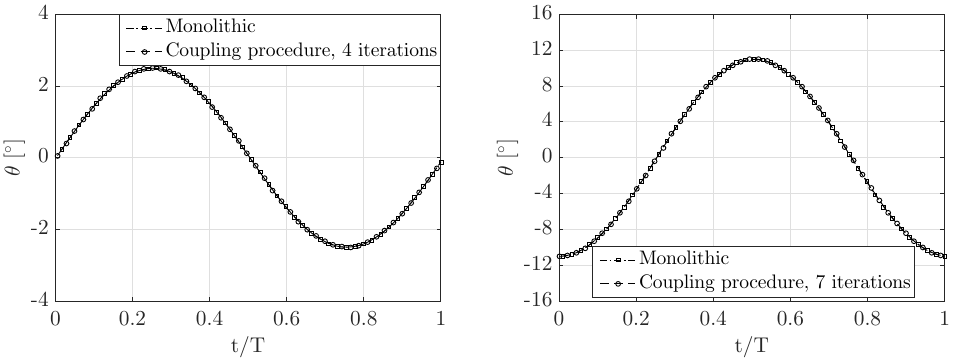
Figure 9. Comparison of monolithic and coupling procedure solution of the predicted pitch motion, θ , as a function of the normalized time, t / T , for ω = 4.83 rad/s ( left ) and ω = 483 rad/s ( right ) graph.